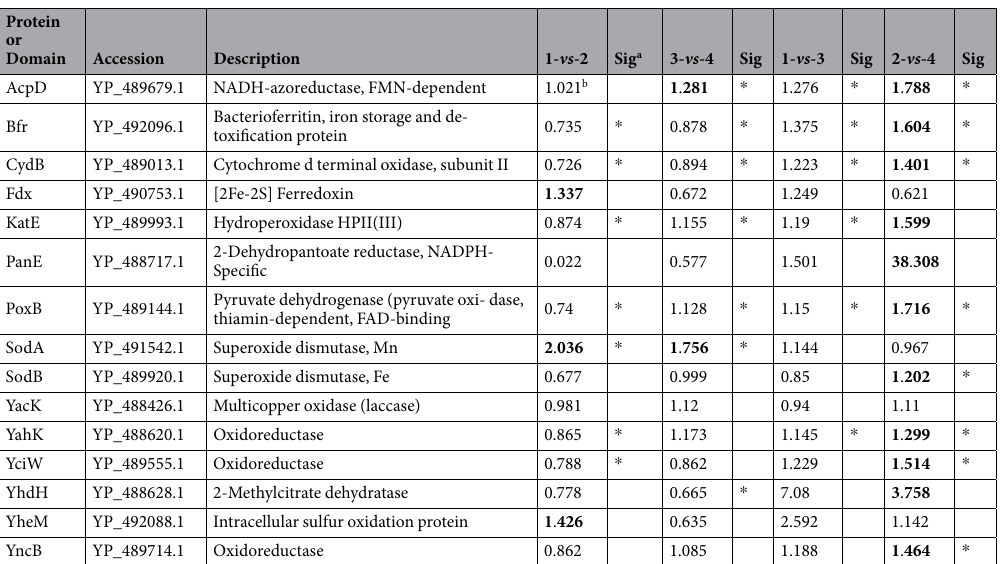
Table 2. Oxidoreductases identified by iTRAQ. Note: a Sig = significance, statistical test of expression difference. * Statistically significant; b the number indicates the fold change of the differential proteins. The four sample pairwise comparisons were as follows: 12 h with 0 mM vs .1 mM Mn(II), 1- vs -2; 48 h with 0 mM vs . 1 mM Mn(II), 3- vs -4; 12 h vs .48 h with 0 mM M (II), 1- vs -3; and 12 h vs .48 h with 1 mM Mn(II), 2- vs -4. The bold values represent up-regulated expression ( > 1.2